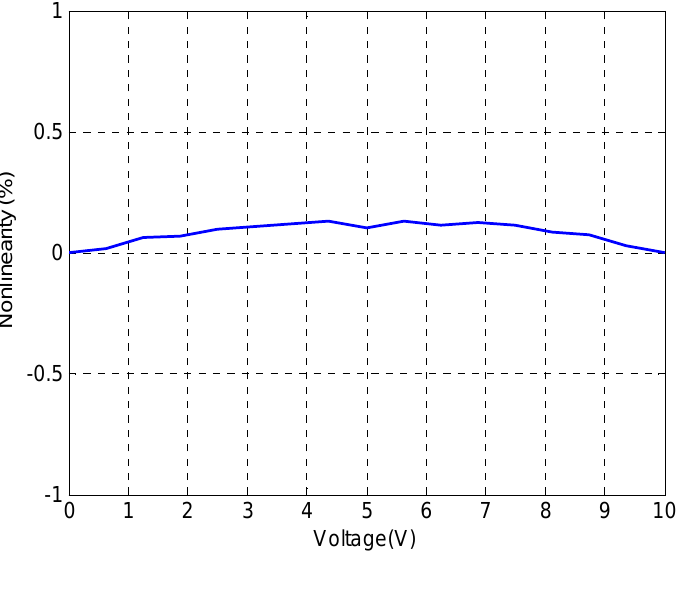
Figure 8. Nonlinearity of the measurement of SGS